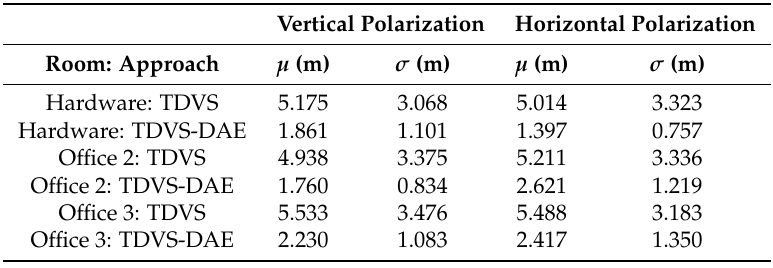
Table 3. Localization performances of the